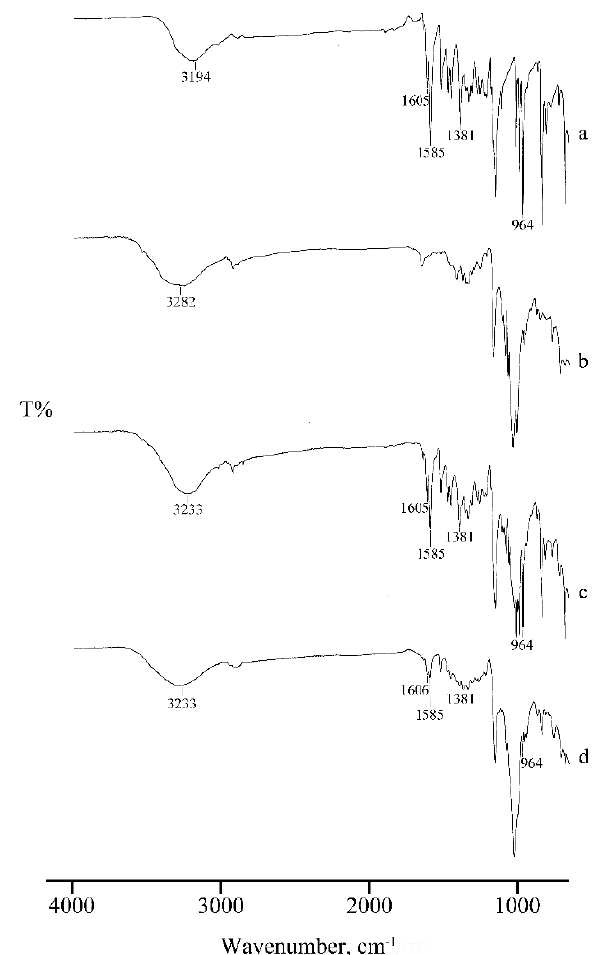
Figure 6. FT-IR spectra of RSV ( a ), α -CD ( b ), their PM ( c ), and MW product ( d ).